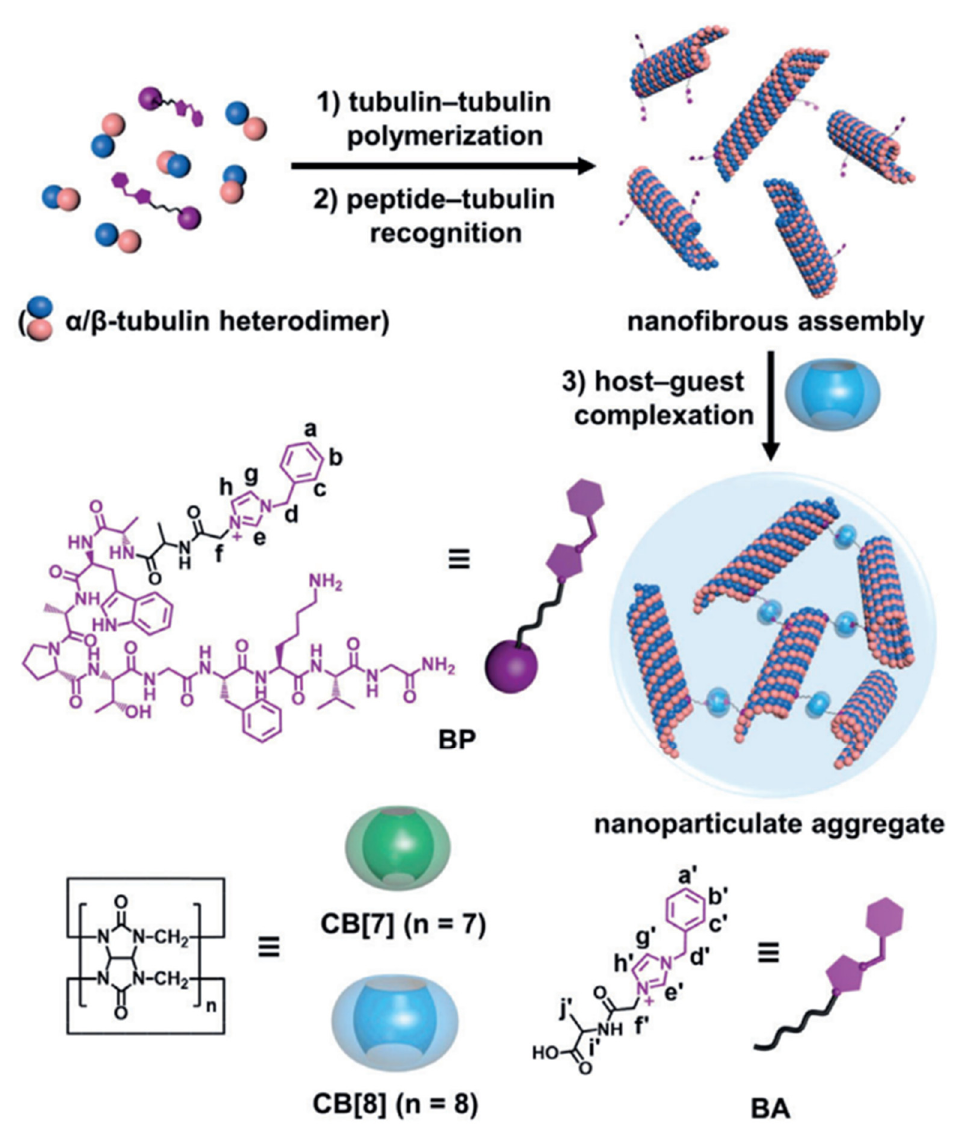
Figure 21. Schematic diagram of ternary supramolecular (BP-CB[8])@MT combination for targeting microtubule assembly (reproduced with permission of John Wiley & Sons, Inc. from ref. [97]).